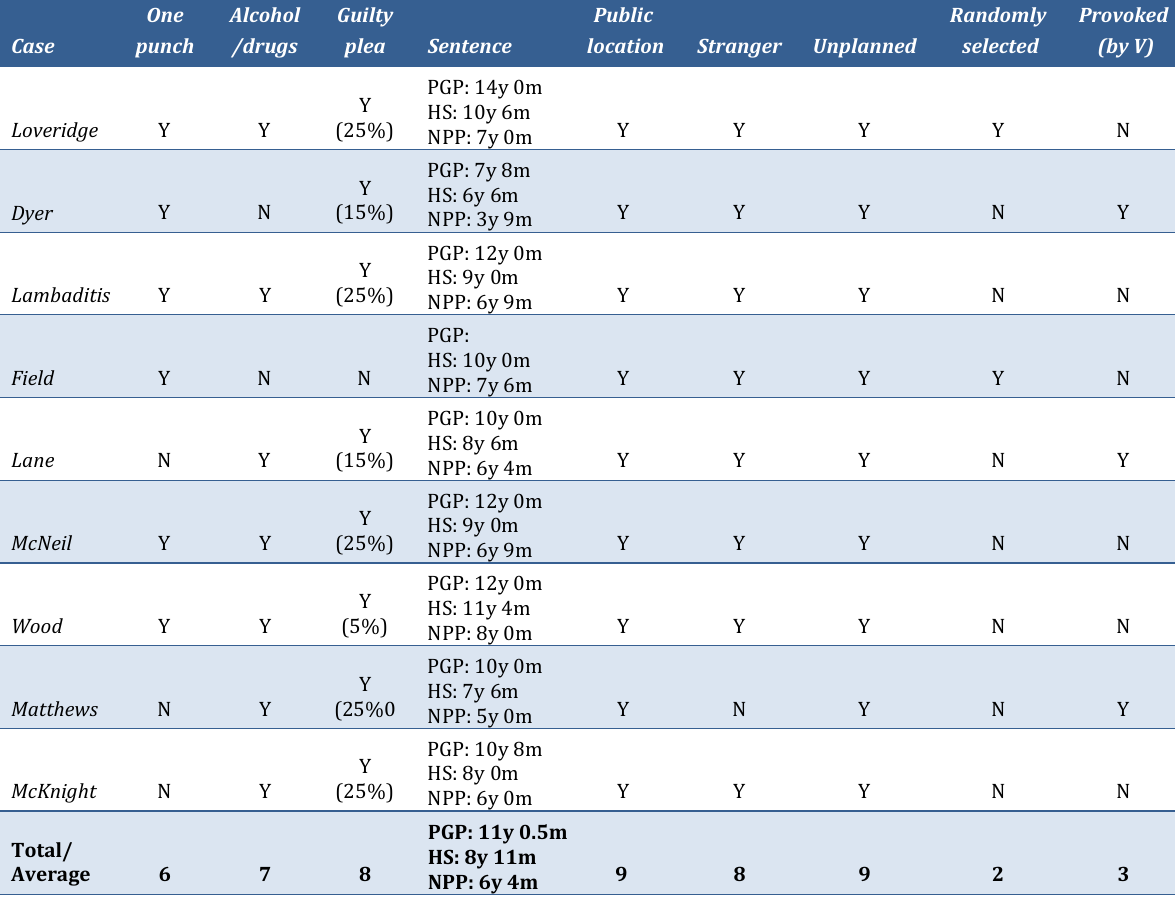
Table 1: ‘ Loveridge category’ cases in NSW, 2014 ‐